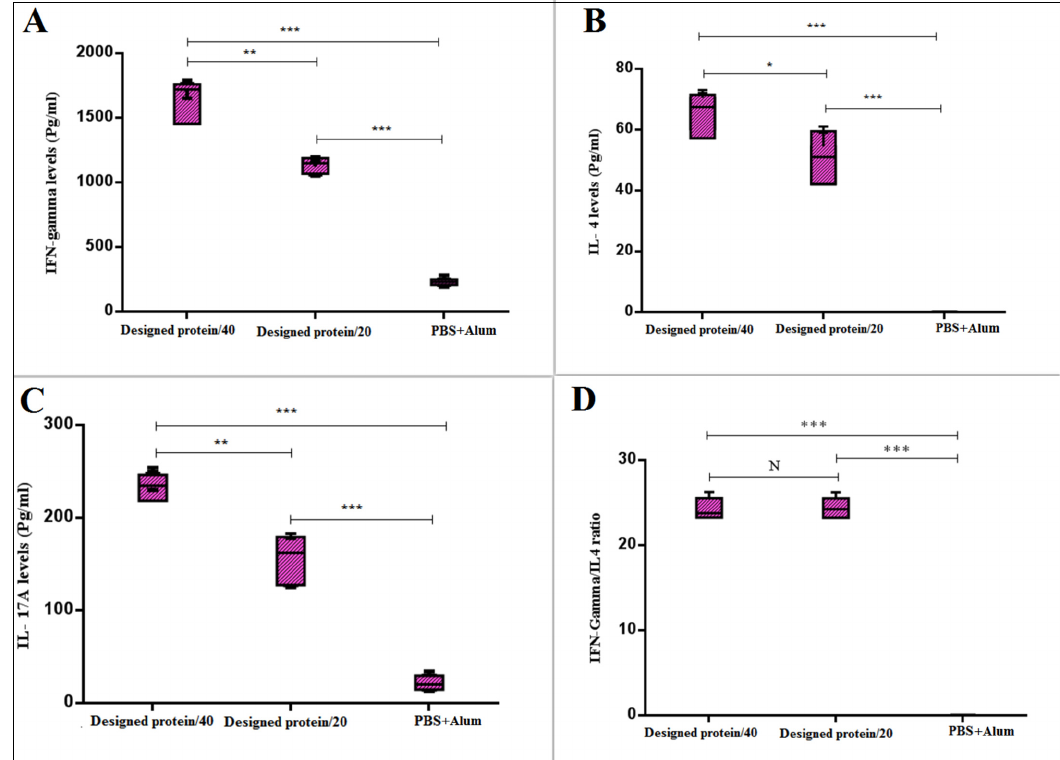
Figure 5. Analysis of the cytokine response in the immunized mice with 20 and 40 µg of GPEHT protein candidates and PBS+Alum. Mice were sacrificed 14 days after the third injection. Splenocytes from each mouse group were prepared and promoted with the GPEHT protein for 72 h, and the supernatants were evaluated for the secretion of ( A ) IFN- γ , ( B ) IL-4, and ( C ) IL-17 levels. ( D ) IFN- γ /IL-4 ratio. Outcomes are the mean stimulation index ± S.D. of six mice per group from three independent experiments. *** for p < 0.0001, ** for p < 0.001, and * for p < 0.01. N for No Significant